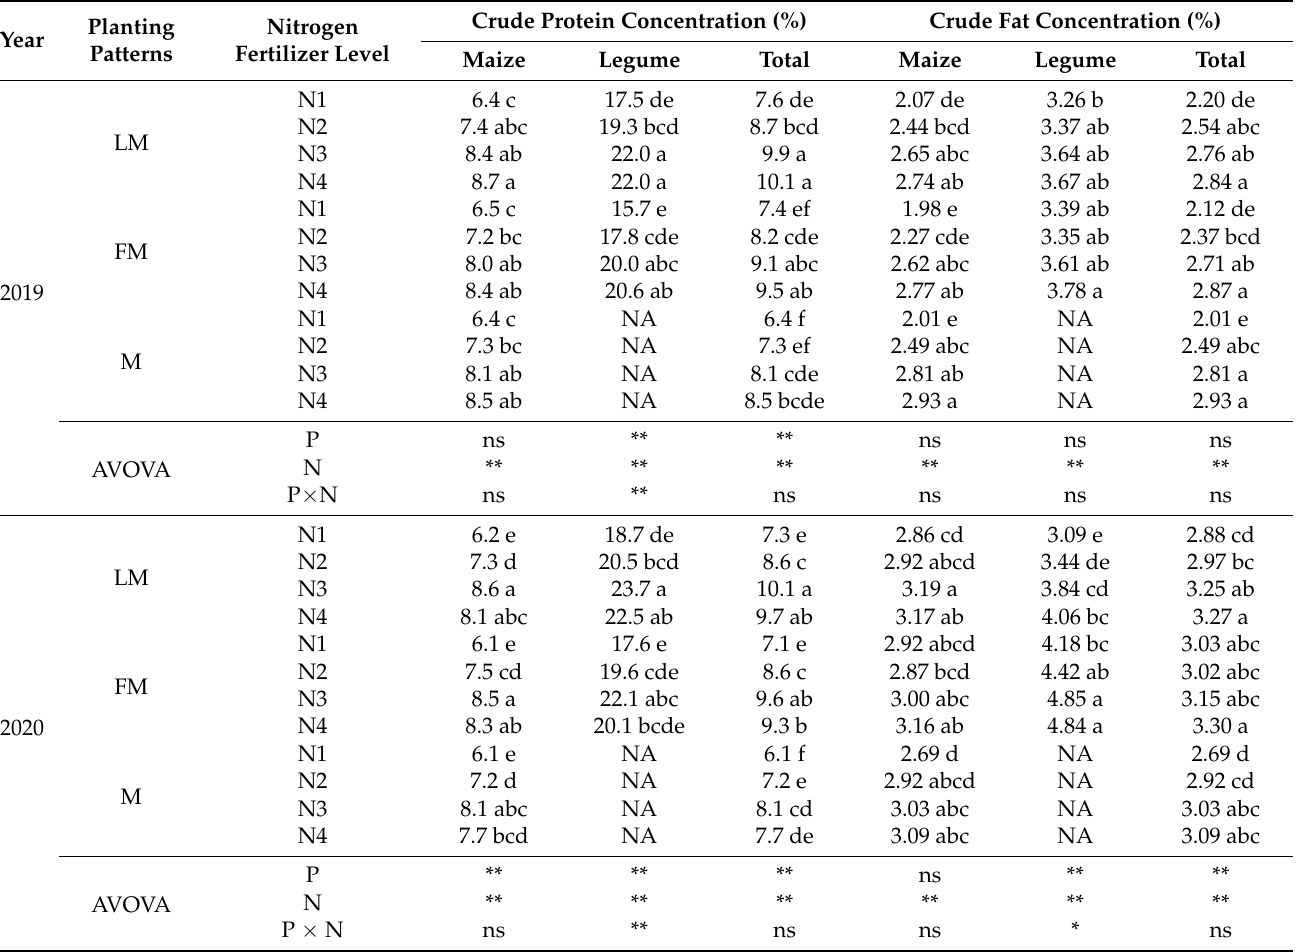
Table 1. Crude protein and crude fat concentration of silage maize and leguminous crops under different treatments in 2019 and